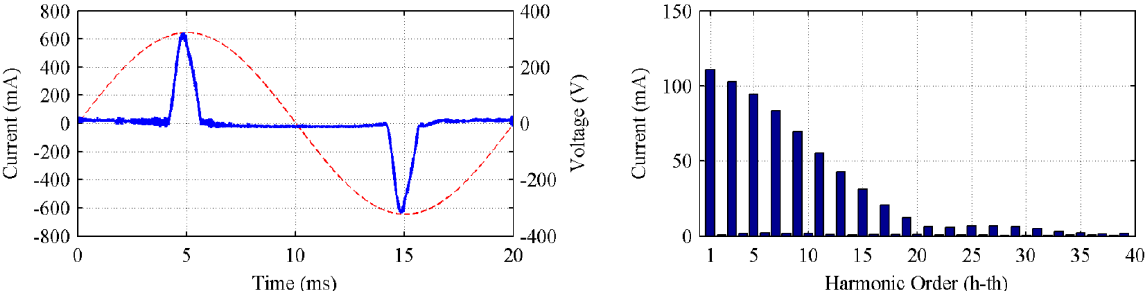
Figure 2. LED panel of 21 W without dimming: Current waveform and its harmonic